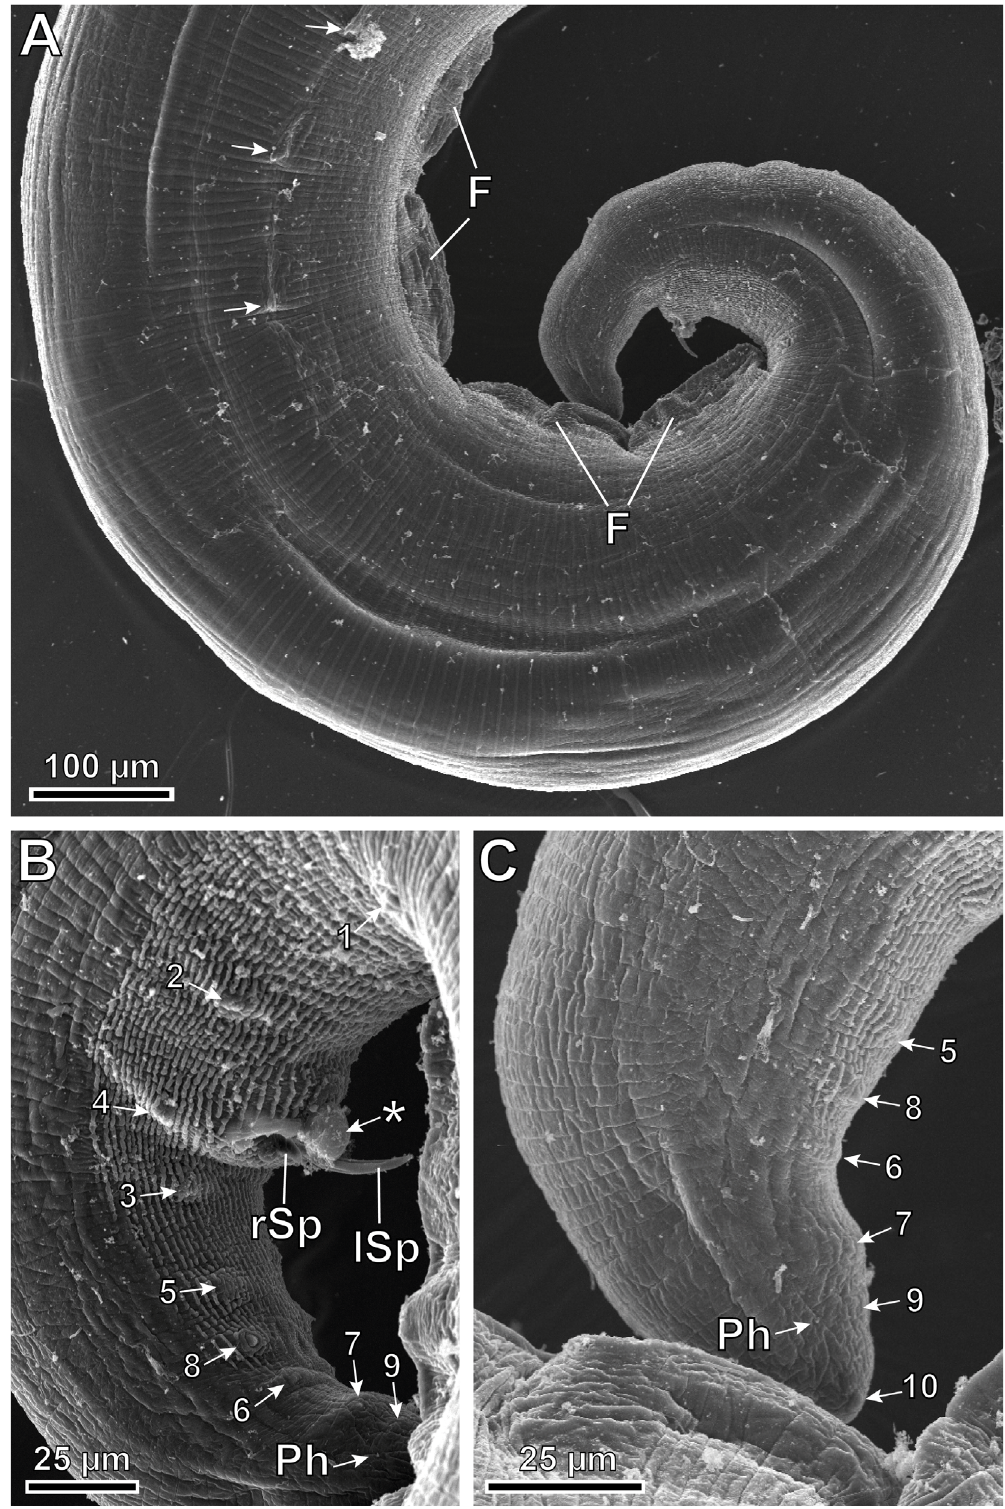
Figure 8. Pterygodermatites ( Mesopectines ) valladaresi n. sp., male, scanning electron microscopy. (A) Caudal extremity showing four midventral fans and the three last cuticular spines (arrows); (B) Detail of the cloacal region illustrating the location of papillae; (C) Detail of the posterior tip showing the location of papillae. *, unpaired precloacal papilla; 1 – 10, pairs of cloacal papillae; F, fans; lSp, left spicule; Ph, phasmids; rSp, right